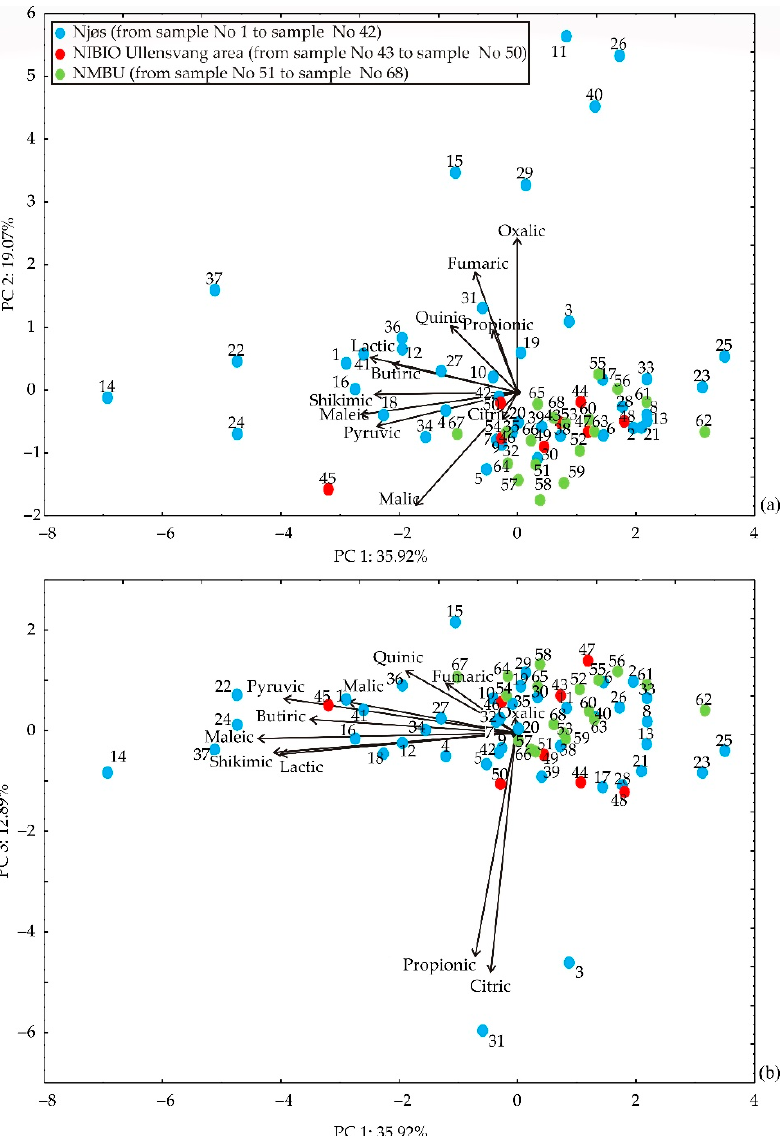
Figure 4. PCA ordination of fruit acids content variables: ( a ) projection in PC1-PC2 plane; ( b ) projection in PC1-PC3 plane.